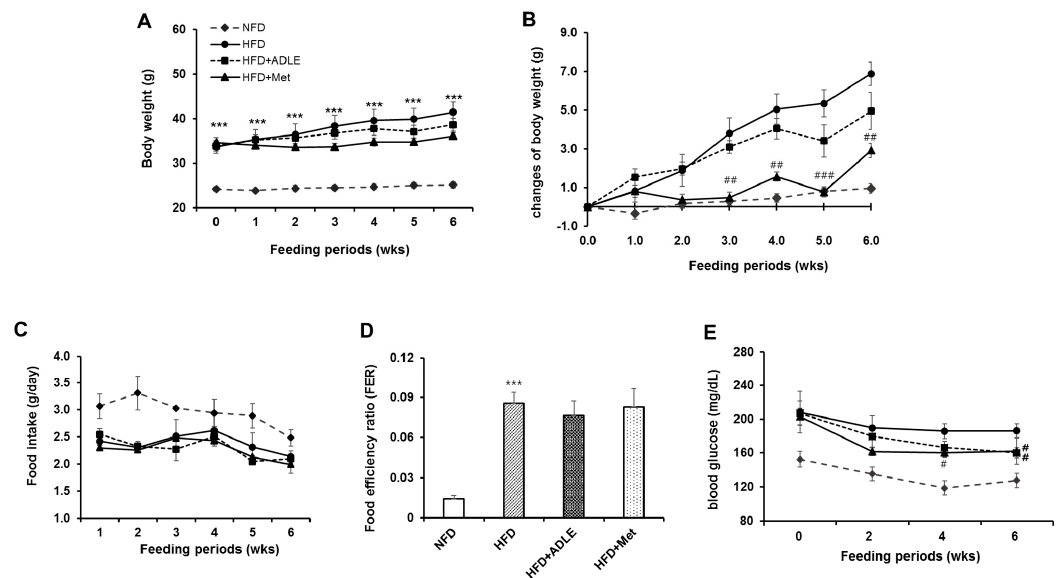
Figure 1. Treatment of ADLE reduced body weight and blood glucose level of HFD-induced diabetic mice. High-fat diet-induced diabetic mice were treated with vehicle, Allomyrina dichotoma larva extract (ADLE, 100 mg / kg) or metformin (Met, 100 mg / kg) for 6 weeks. ( A ) Body weight for 6 weeks, ( B ) changes in body weight for 6 weeks, ( C ) food intake (g / day), ( D ) FER over 6 weeks, and ( E ) fasting blood glucose levels for 6 weeks. Values are presented as means ± SD ( n = 6–8). *** p < 0.001 vs. NFD group. # p < 0.05, ## p < 0.01, and ### p < 0.001 vs. HFD group. NFD, normal-fat diet; HFD, high-fat diet; HFD + ADLE, high-fat diet + ADLE; HFD + Met, high-fat diet + Met.